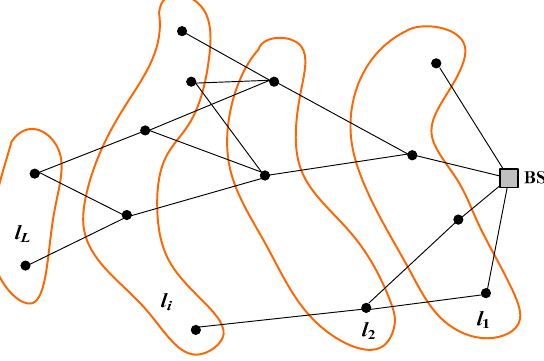
Figure 4. Layer decomposition of a connected network. Lines represent feasible links for the given transmission range. Only inter-layer links are drawn. BS denotes the base